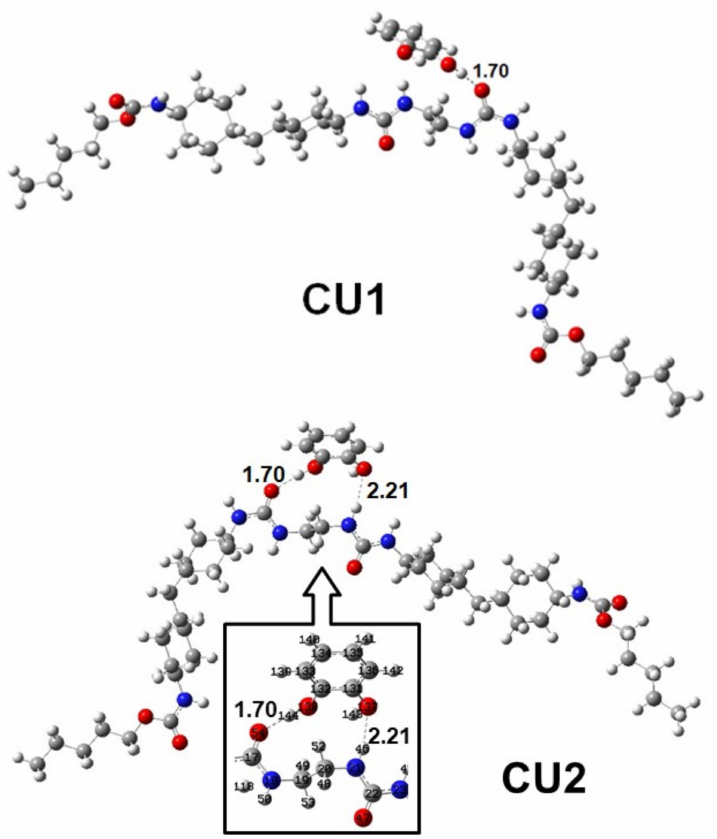
Figure 4. Catechol binds with urea group of WBPU through two approaches. In the CU1 approach, catechol forms one hydrogen bond with the carbonyl group of urea and in CU2, it forms two hydrogen bonds with two urea groups. The inside figure is a close view of the interaction between catechol and WBPU with atom